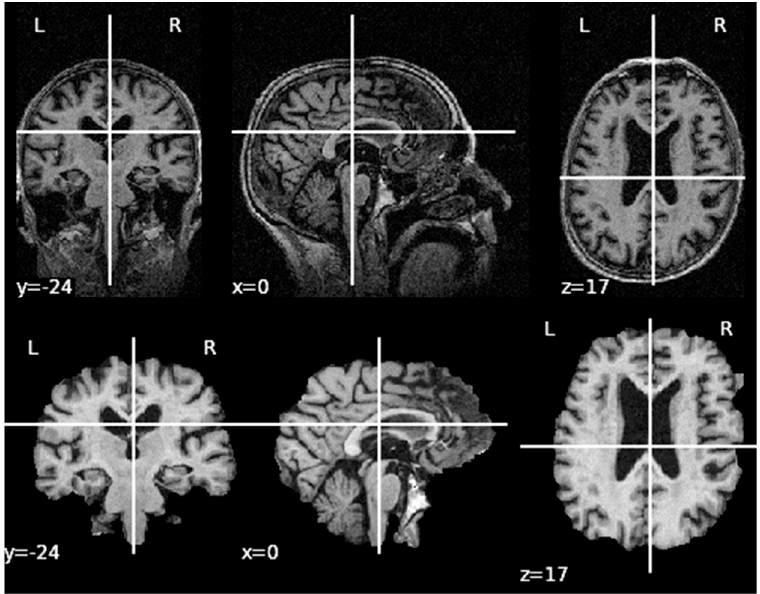
Figure A2. MRI volume prior to processing (upper row) and after skull removal processing (bottom row). Column A: coronal plane, column B: sagittal view and column C: axial plane.